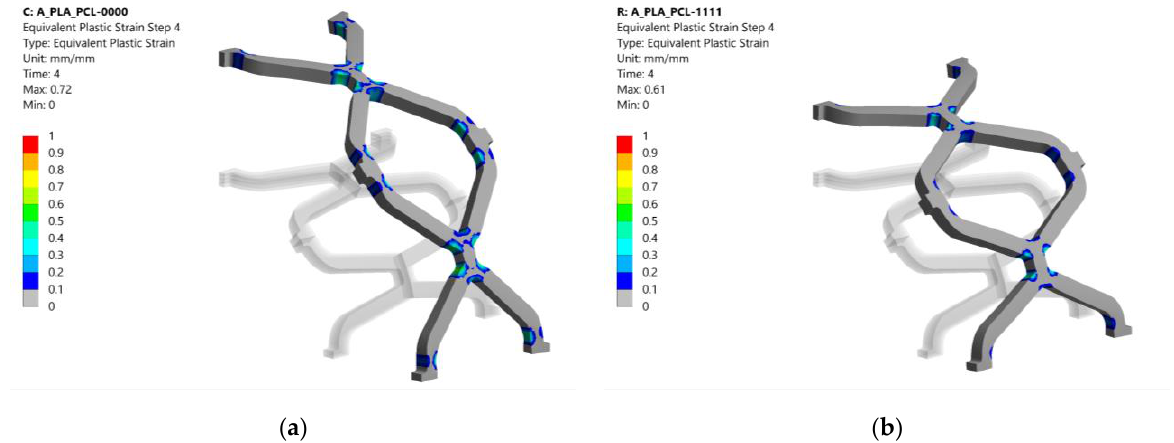
Figure 9. Equivalent plastic strain results after the last numerical analysis step for configurations 0000 and 1111 (deformation scale factor: 1): ( a ) plastic strain after balloon removal for configuration 0000; ( b ) plastic strain after balloon removal for configuration 1111. Table 4. Equivalent plastic strain after final analysis step for different material